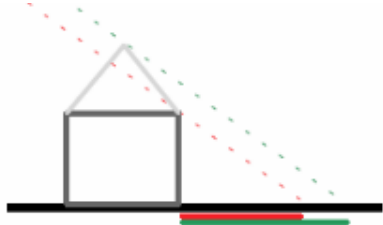
Figure 3. Effect of LoD1 and LoD2 in shadow calculation.